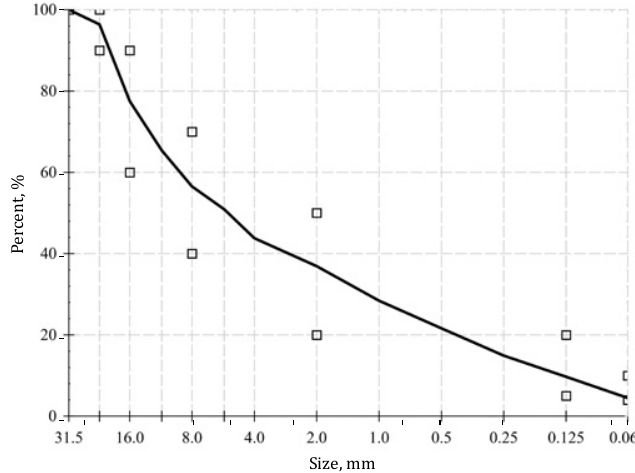
Figure 13. Grading of the mineral mixture extracted from the recycled asphalt pavement material